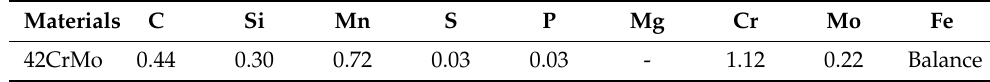
Table 1. The chemical composition of 42CrMo Steel (wt. %).